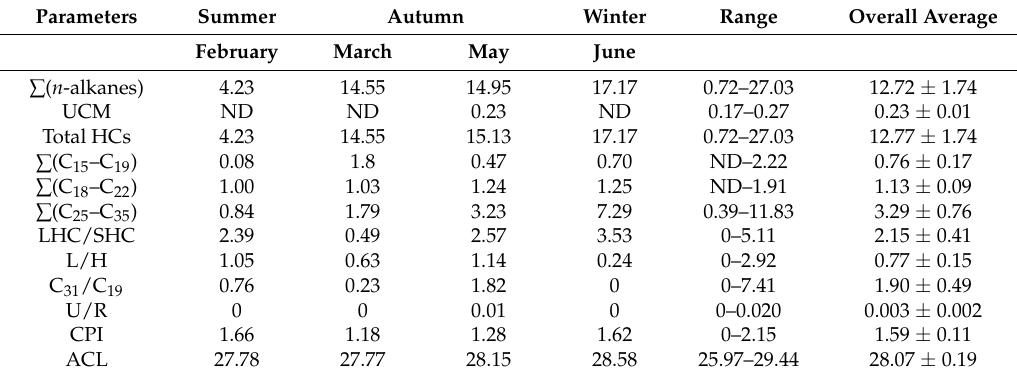
Table 6. Average concentration of hydrocarbons in the bay sediment (mg/kg) and sources diagnostic ratios.